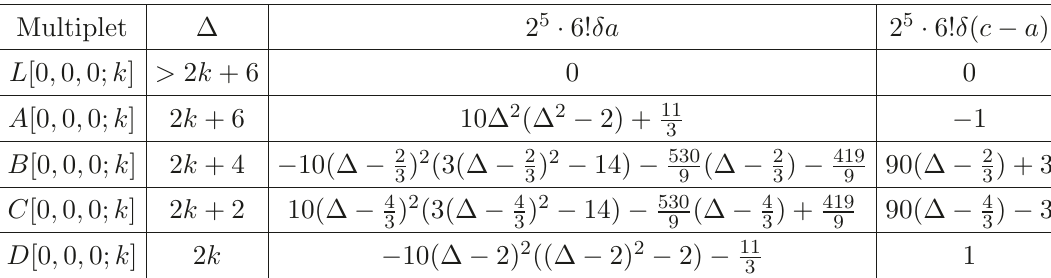
Table 3 . Contribution to the Weyl anomaly coefficients δa and δc from maximum spin two mul- tiplets for the N = (1 , 0) theory. Here c is related to the conventional anomaly coefficients c i according to (2.4). The δa coefficient is computed using the results of